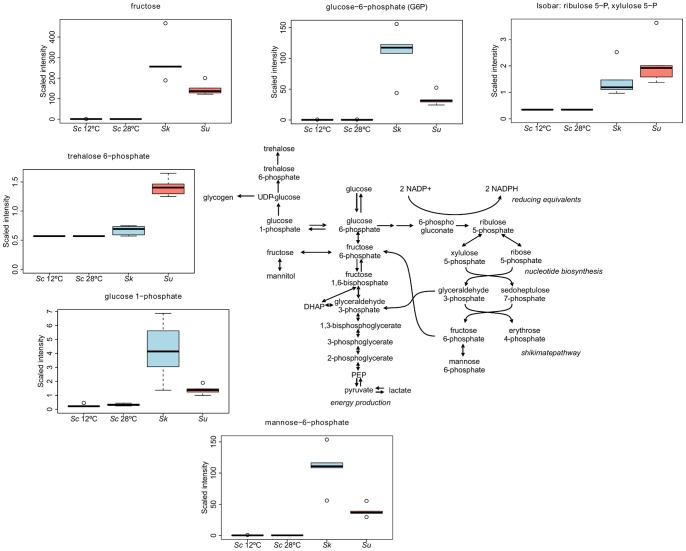
Carbohydrate metabolism: glycolytic pathway, trehalose synthesis, intermediates of the pentose phosphate pathway and protein mannosylation.Differentially produced metabolites within Su and Sk compared to Sc. Box legend: bar inside the box represents the median value, upper bar represents maximum of distribution, lower bar represents minimum of distribution, and the circle represents extreme data points.